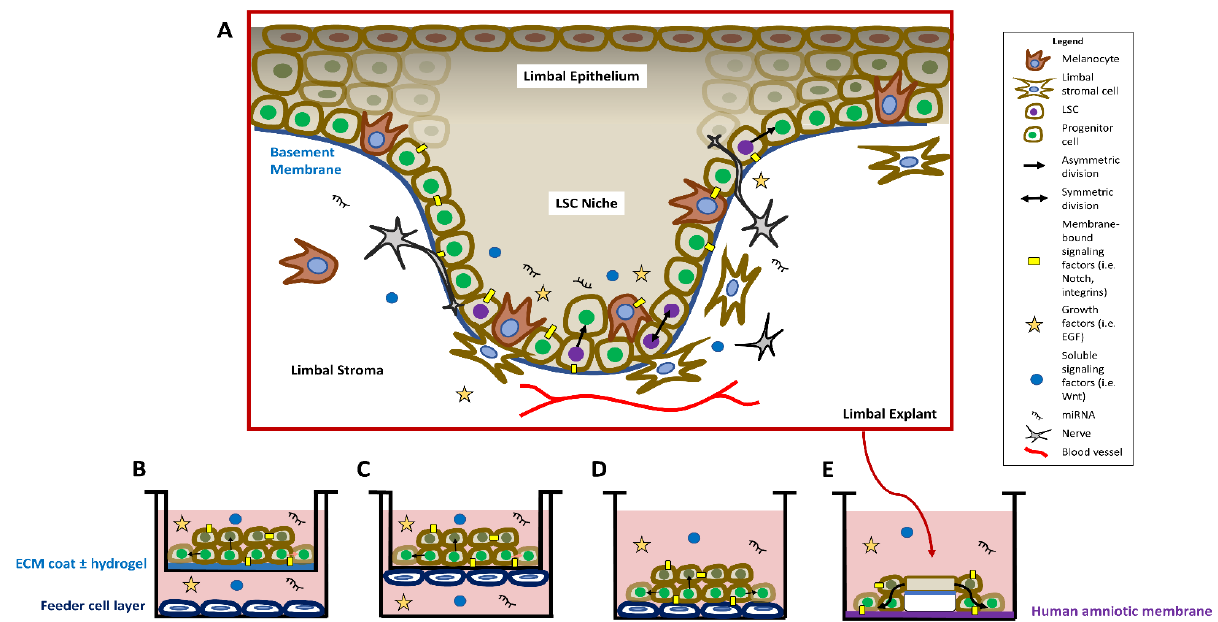
Figure 1. Overview of the structure of the in vivo compared to the in vitro limbal stem cell (LSC) niche. ( A ) In the in vivo niche, LSCs reside primarily in the basal limbal epithelium in the crypts or Palisades of Vogt. Quiescent LSCs (purple nuclei) can be activated to divide asymmetrically into proliferative progenitor cells (green nuclei), or divide symmetrically to maintain the stem cell pool. LSC regulation is maintained by soluble and membrane-bound signaling factors, and microRNAs. The limbal niche harbors melanocytes, nerves, blood vessels, and stromal cells that contribute to the support of the LSCs. ( B – E ) Four commonly used methods of in vitro LSC culture. ( B ) LSCs receive structural support from an ECM-and/or hydrogel-coated cell culture insert. Growth factors are provided to the LSCs through a feeder cell layer and the growth medium. ( C ) In the 3D culture model, LSCs and the 3T3 feeder layer are grown on opposite sides of a transwell membrane. ( D ) LSCs are cultivated directly on top of the feeder cell layer, which provides both structural support and growth factors. ( E ) A limbal explant is seeded on a human amniotic membrane, and LSCs proliferate and migrate from the explant.